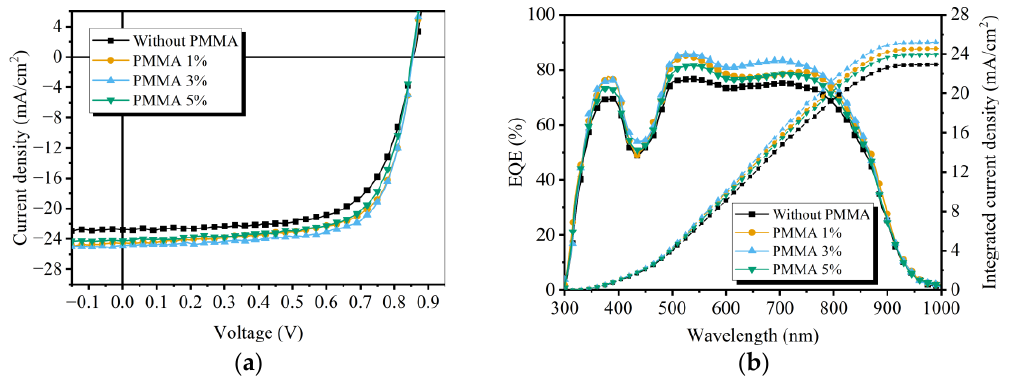
Figure 2. ( a ) J–V curves of OSCs. ( b ) EQE spectra of OSCs. Figure 2. ( a ) J – V curves of OSCs. ( b ) EQE spectra of